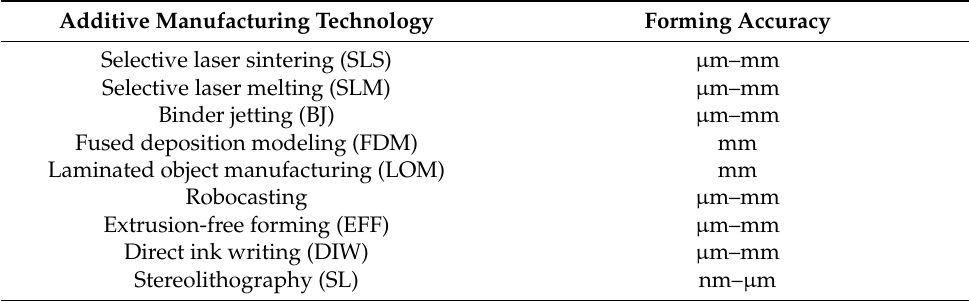
Table 2. Various additive manufacturing technologies for complex-shaped ceramics